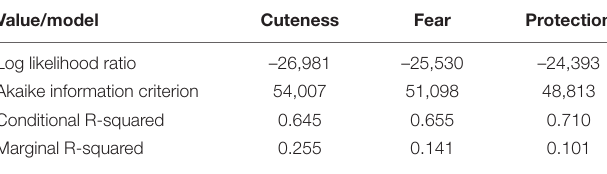
TABLE 6 | Log Likelihood-ratio, Akaike information criterion, marginal, and conditional r-squared values of cumulative link mixed